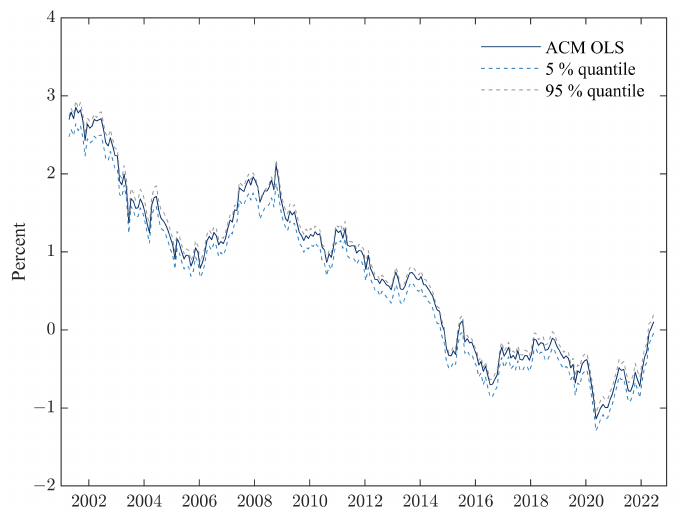
Figure 9. Simulated confidence band for the 10 y term premia using the ACM model. Sample period: 2001/04 to 2022/06.